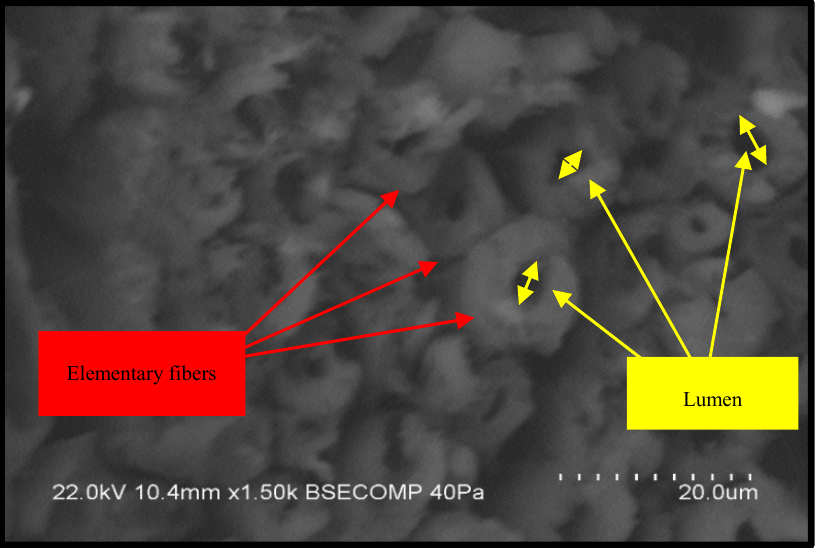
Figure 4. SEM cross-section of PS fibers.